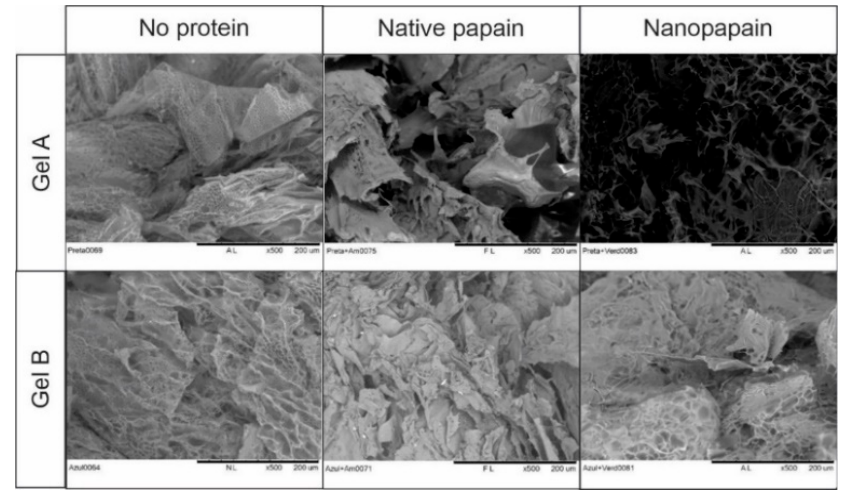
Figure 3. Scanning Electron Microscope (SEM) images of all gel formulations (500× magnification).